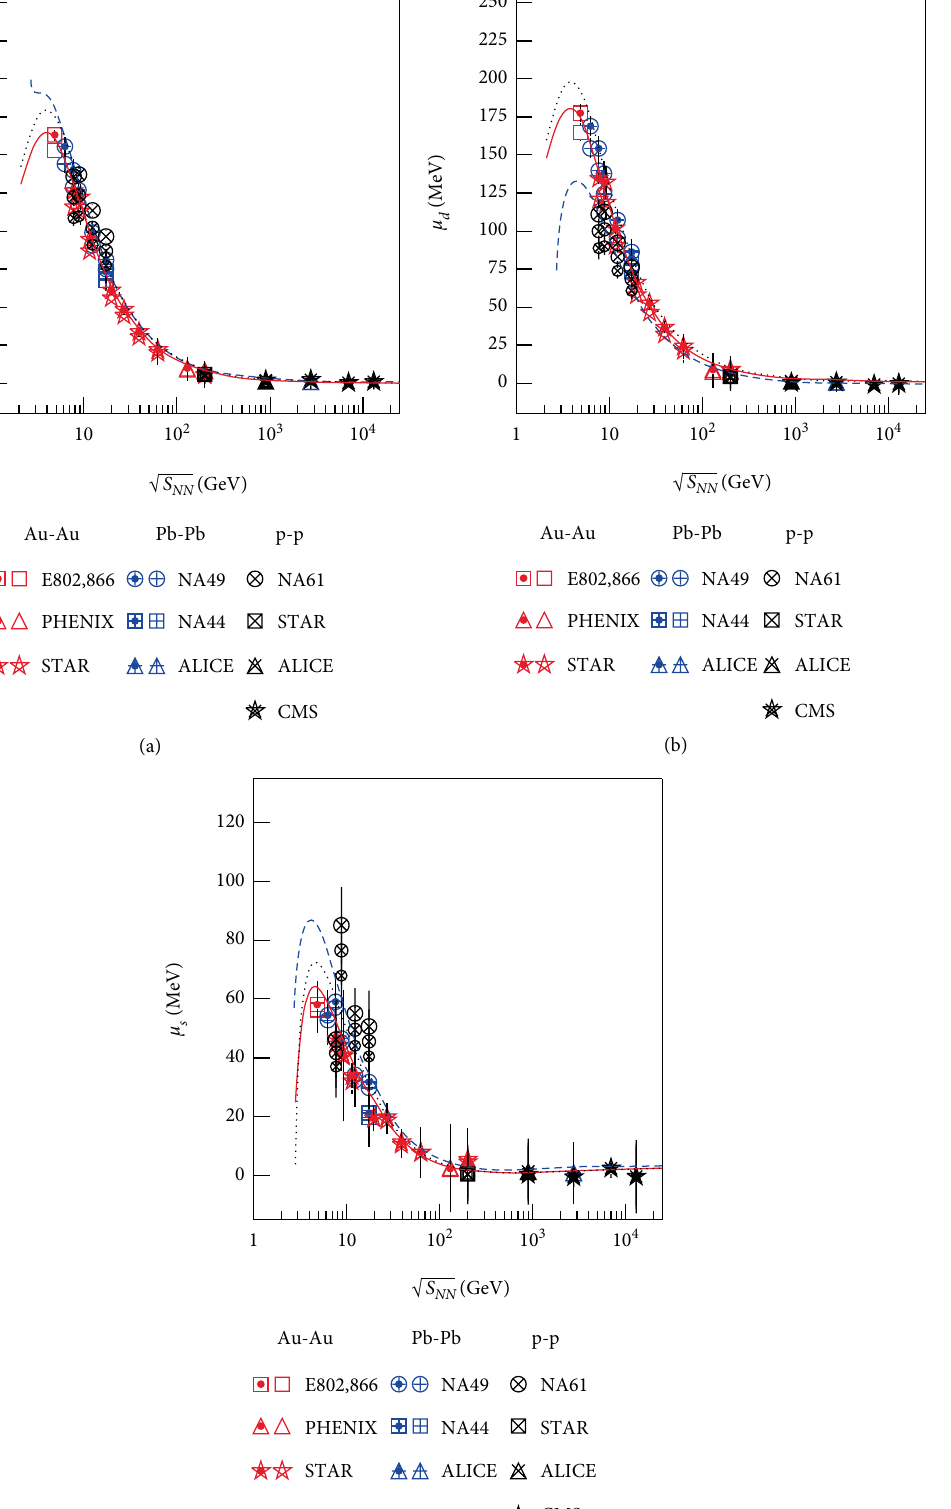
, (b) , and (c) , of (a) , (b) , and (c) quarks according to 𝜇 𝑢 𝜇 𝑑 𝜇 𝑠 𝑢 𝑑 𝑠